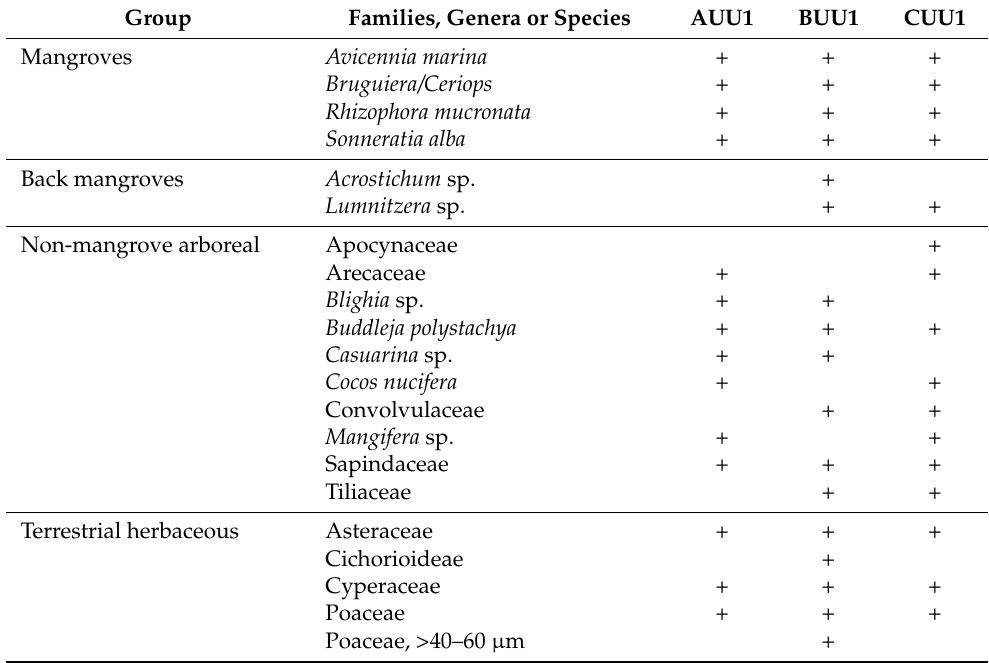
Table 2. Pollen taxa present in sediment cores from Unguja Ukuu. Groups are according to ecological habitats and typical mangrove zonation in Zanzibar according to [9] with a ‘+’ indicates presence of pollen taxa in the respective